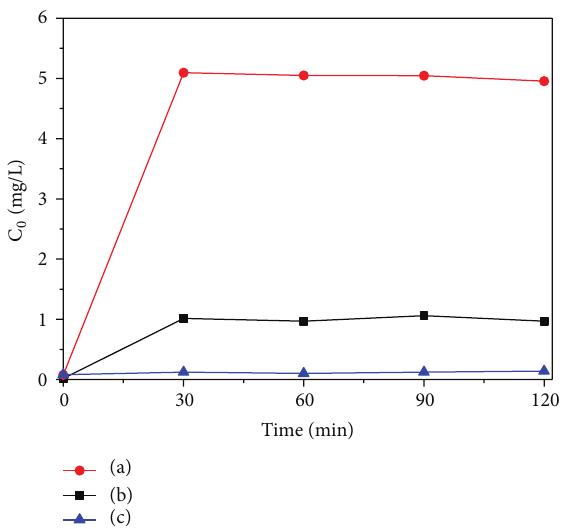
Figure 4: Effect of initial pH value. (a) pH = 2 , (b) pH = 4 , (c) pH = 8 , (d) pH = 6 , and (e) pH = 10